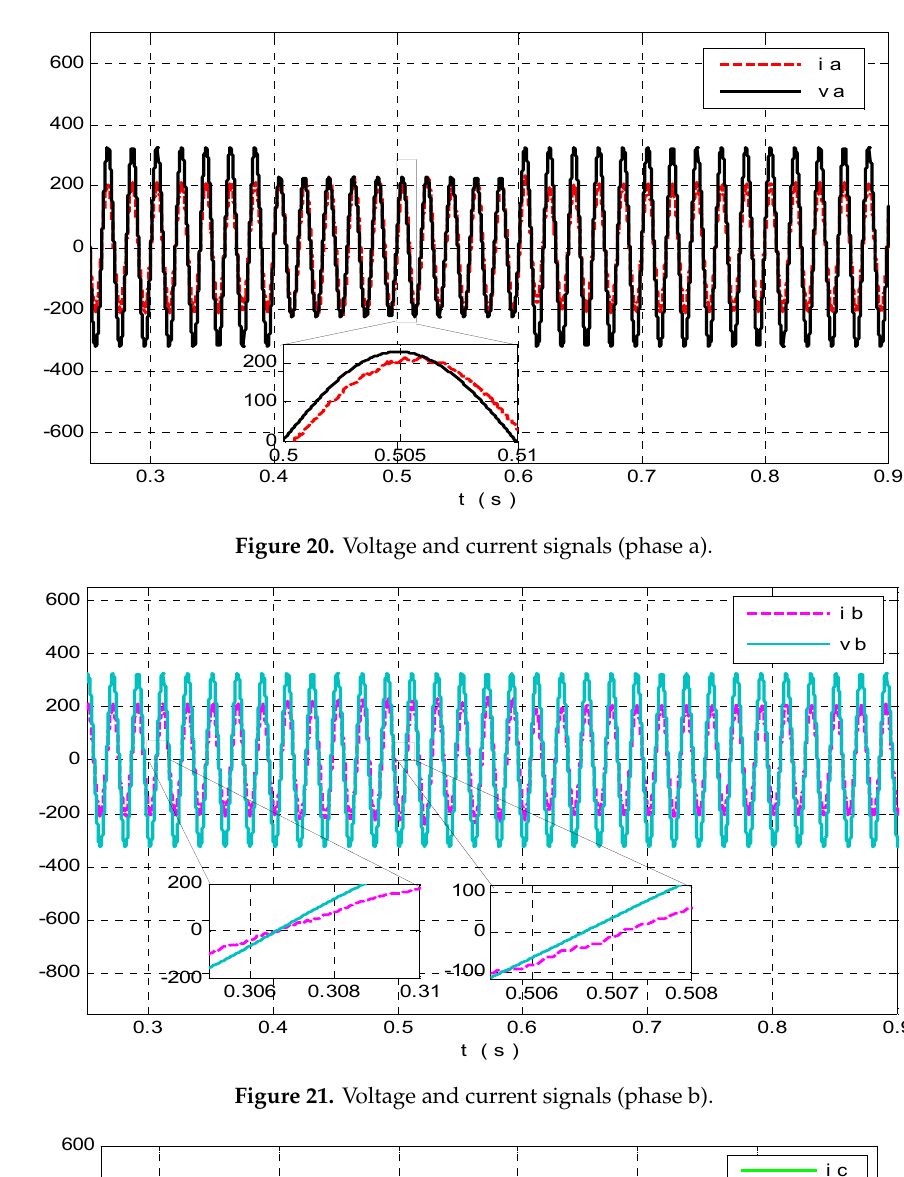
Figure 19. The grid voltage signals.